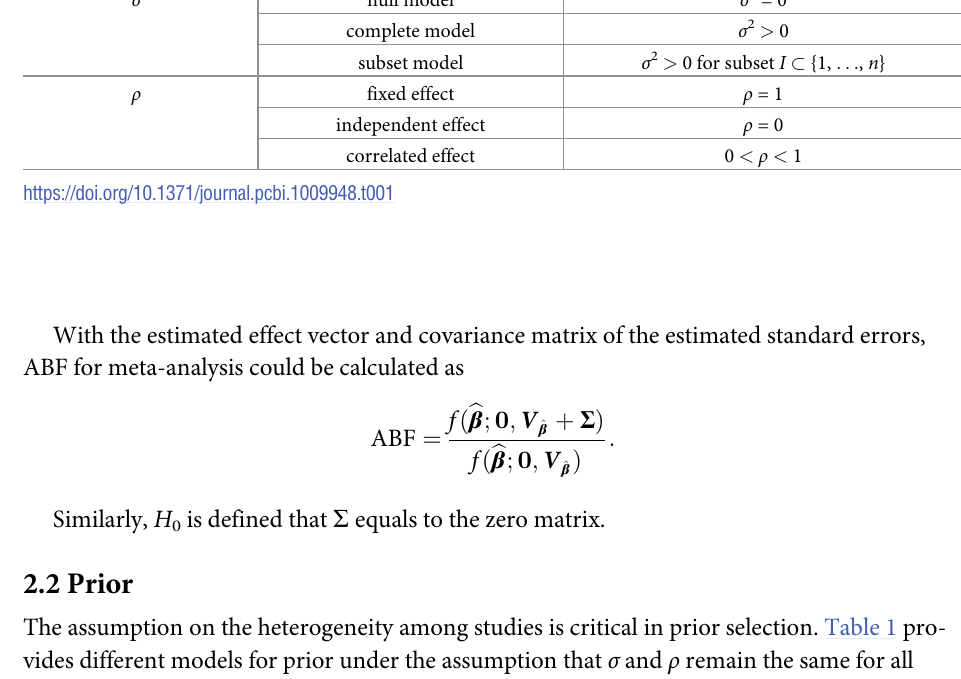
Algorithm 1 MCMC Pseudocode